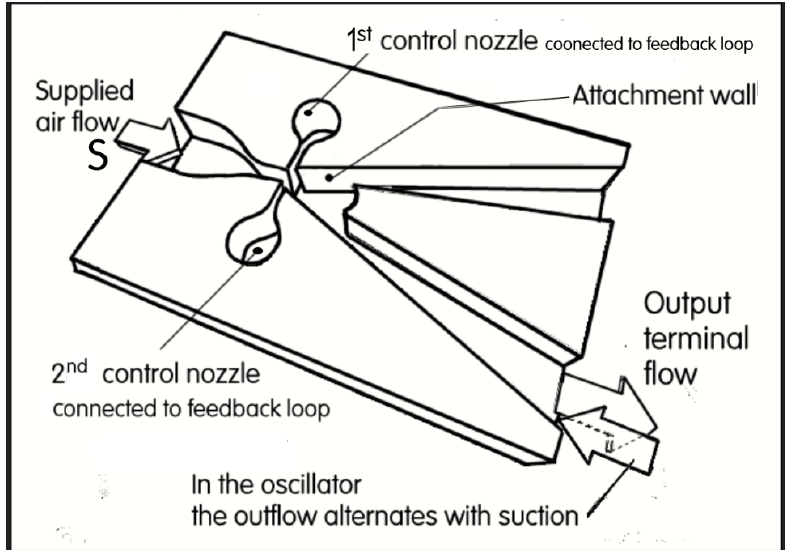
Figure 3. The amplifier used in the Tesa ř -Zimmerman (T-Z) fluidic oscillator. The jet issuing from the supply S is switched by control flow pulses delivered to either X 1 or X 2 and is led by attachment wall to one of the two outputs Y 1 or Y 2 . Between the individual flow pulses directed out from the output terminal there is suction flow generated by the jet-pumping effect as mentioned in [16].